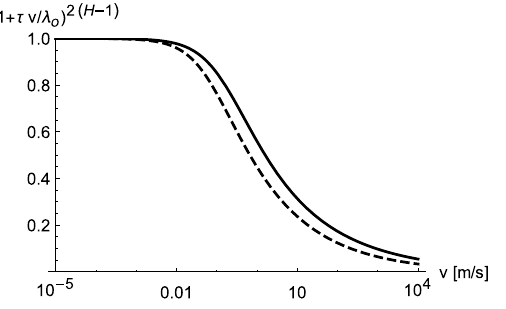
Figure 4. The effect of τ( f ) (solid line) compared to τ ≡ τ c = 2 · 10 − 5 s used to obtain the above results (dashed line). All remaining parameters are identical to those of the P = 1 bar result shown in Fig.